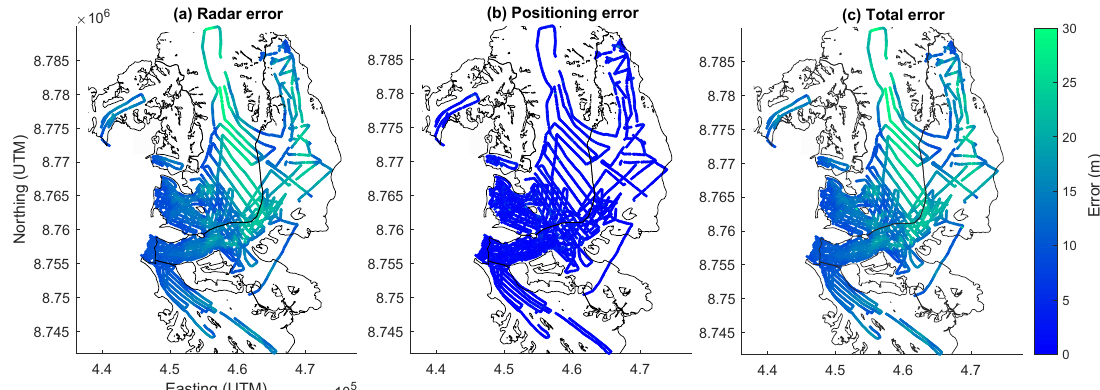
Figure 4. Errors in the subglacial elevation for each data point: (a) radar error consisting of the technical and theoretical capacity of the radar systems, (b) positioning error, and (c) the total error when combining radar and positioning errors. Grid projection is Universal Transverse Mercator Zone